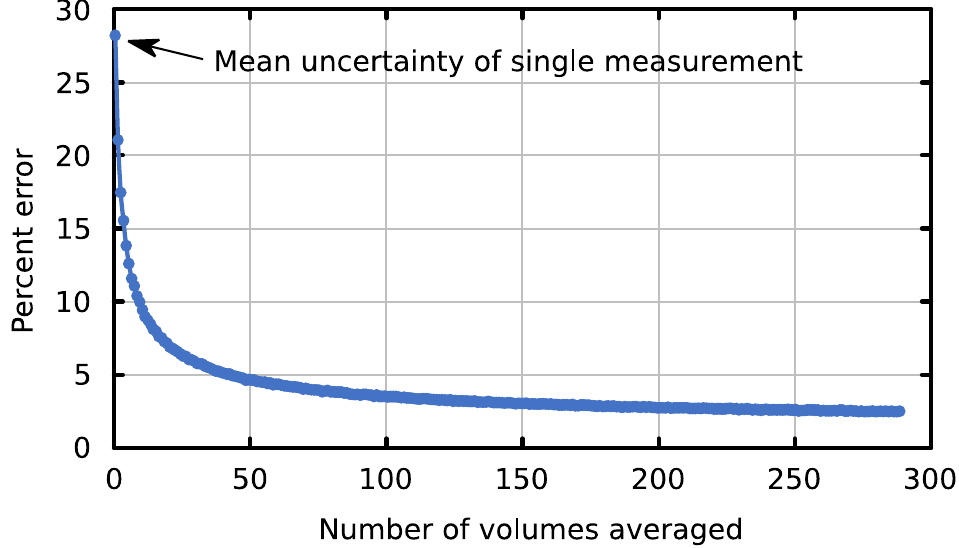
Figure 13. Percent error in power estimate as a function of number of individual power estimates averaged.